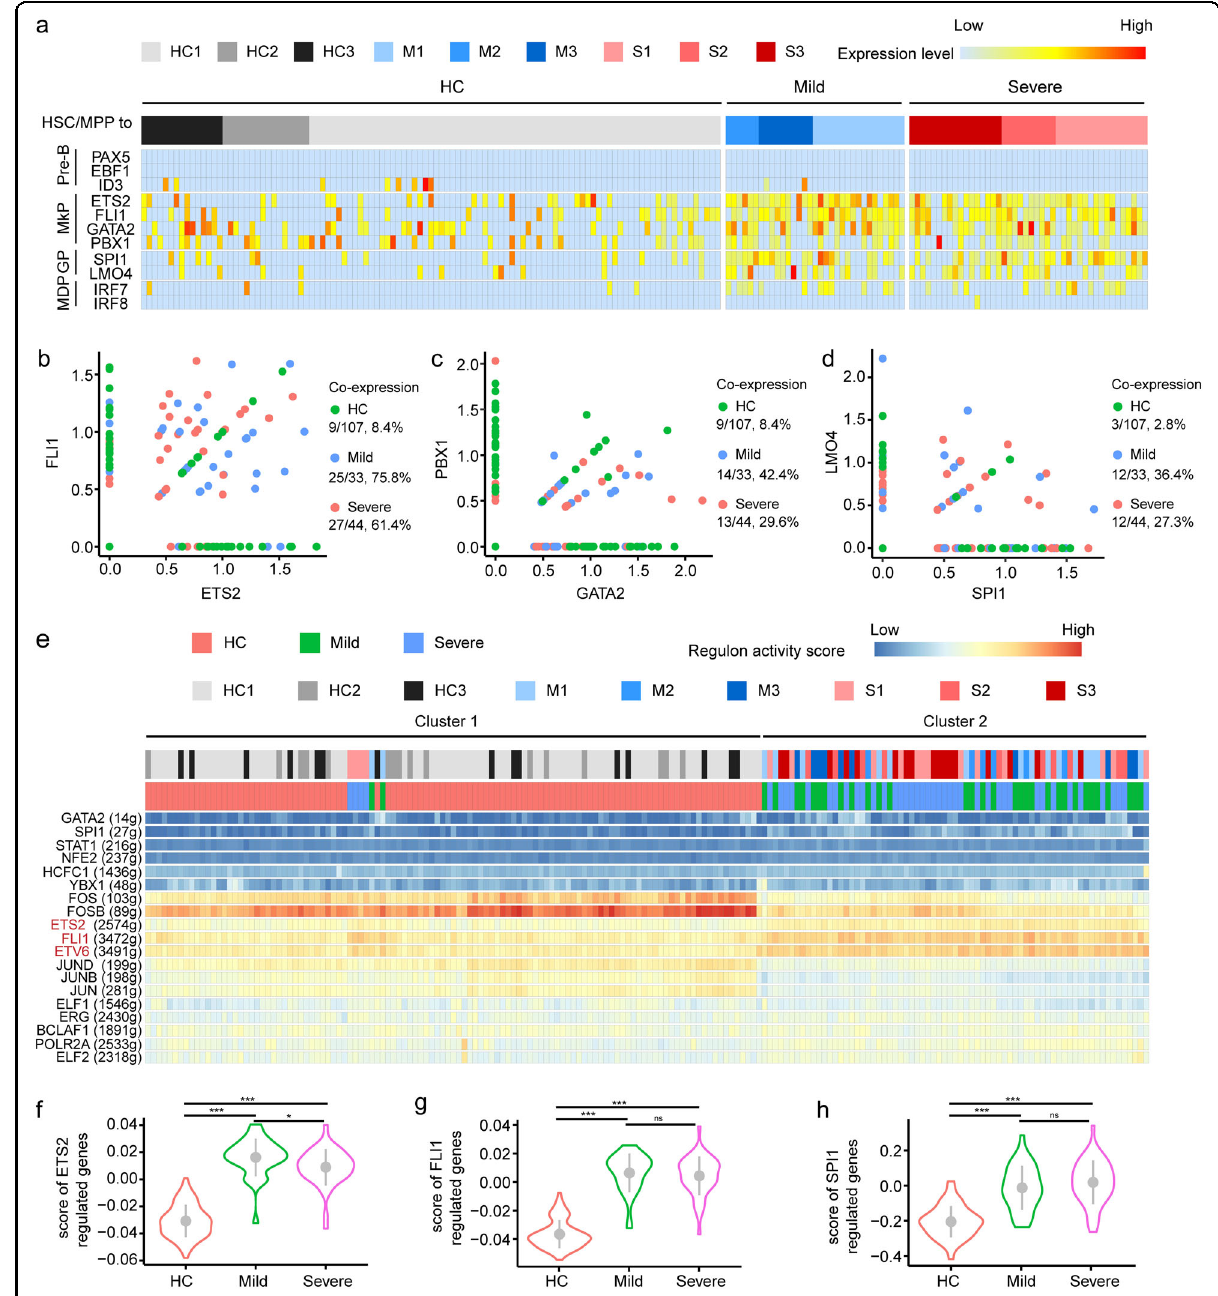
Fig. 4 Transcriptional regulation underlies HSC/MPP from COVID-19 patients. a Heatmap displays the expression levels of lineage-priming TFs for HSC/MPP cells from HCs, mild, and severe patients. Five gene modules involved in hematopoiesis differentiation are presented, including pre-B ( PAX5, EBF1 , and ID3 ), MkP ( ETS2, FLI1, GATA2 , and PBX1 ), GP ( SPI1, LMO4 ), and MDP ( IRF7, IRF8 ). b – d Co-expression of selected TFs was assessed across different groups. e Heatmap showing the regulon activity scores (RASs) of lineage-related TFs for HSC/MPP cells from HCs, mild, and severe patients. 184 HSC/MPP cells were arranged by unsupervised clustering according to their regulon activities. f – h Score of speci fi c TF-regulated genes in three